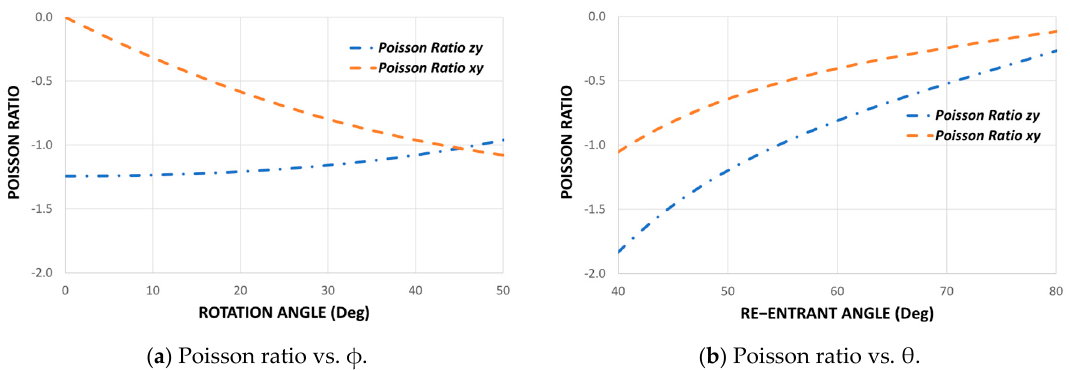
( a ) Poisson ratio vs. ϕ . ( b ) Poisson ratio vs. θ . Figure 3. Average Poisson’s ratio for different values of design parameters 𝜃 and ∅ , considering 𝐻 (cid:3404) 13.6 𝑚𝑚 , 𝐿 (cid:3404) 5.9 𝑚𝑚 and ∅ (cid:3404) ∅ (cid:2869) (cid:3404) ∅ (cid:2870) (cid:3404) 22.5° . H = 13.6 mm, L = 5.9 mm and ∅ = ∅ 1 = ∅ 2 = 22.5 ◦